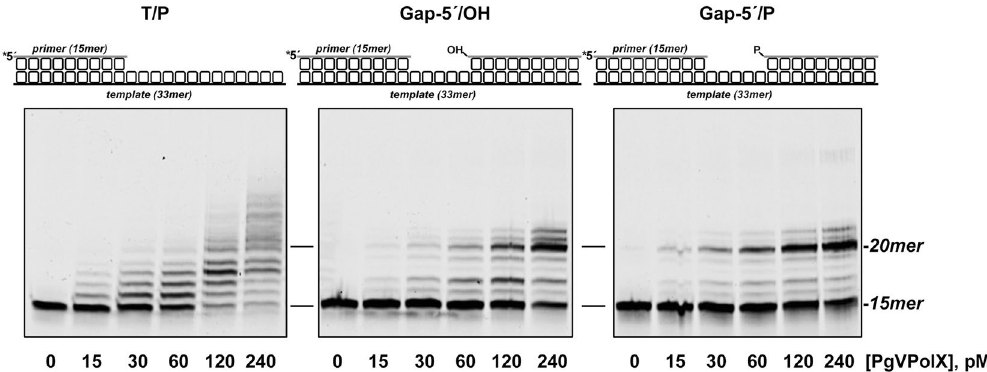
Figure 3. DNA substrate preference for PgVPolX. The following different molecules used in the analysis: T/P , template-primer; Gap-5 ′ /OH , 5 nucleotides gap; and Gap-5 ′ /P , 5 nucleotides gap bearing a 5 ′ -phosphate group are schematized on top of the figure. The assay was carried out as described in Materials and Methods with 25 nM DNA substrate and 100 µ M dNTPs. Asterisks indicate the 5 ′ Cy5-labeled end of the primer